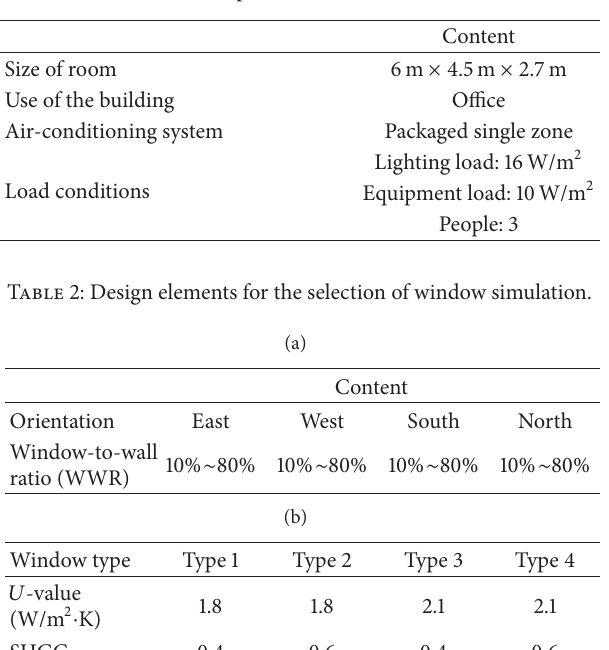
Table 1: Unit space simulation information.